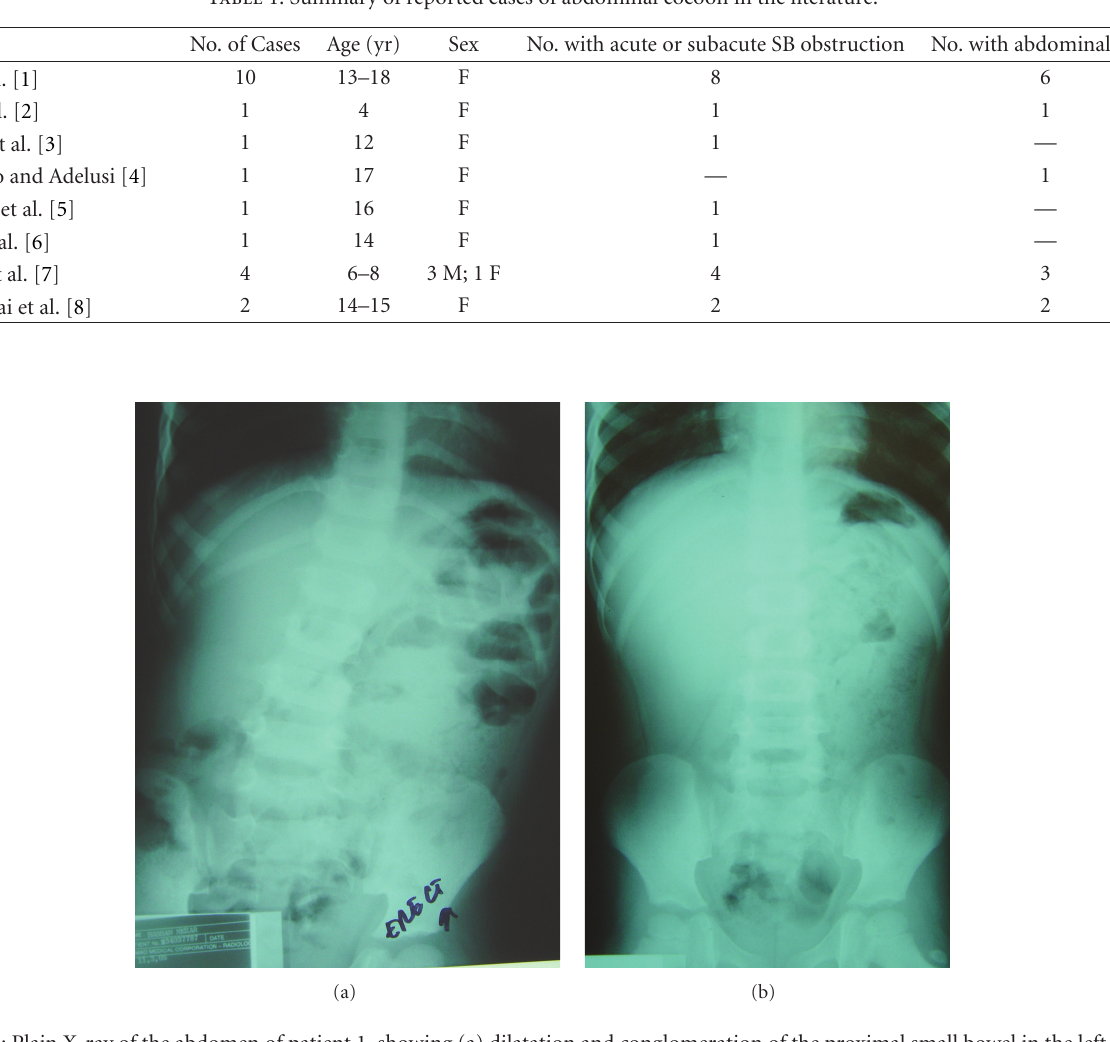
Table 1: Summary of reported cases of abdominal cocoon in the literature.